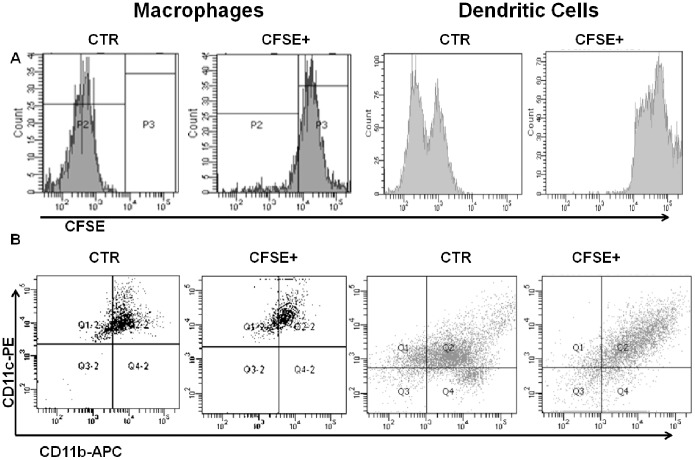
CFSE-labeling does not alter phenotype.A) BMDM and BMDC were fluorescent-labeled with 2 µM CFSE. B) Representative dot plots (1 out of 3 independent experiments) show that control (CTR) and CFSE-labeled macrophages (CFSE) had similar CD11b and CD11c expression profiles.